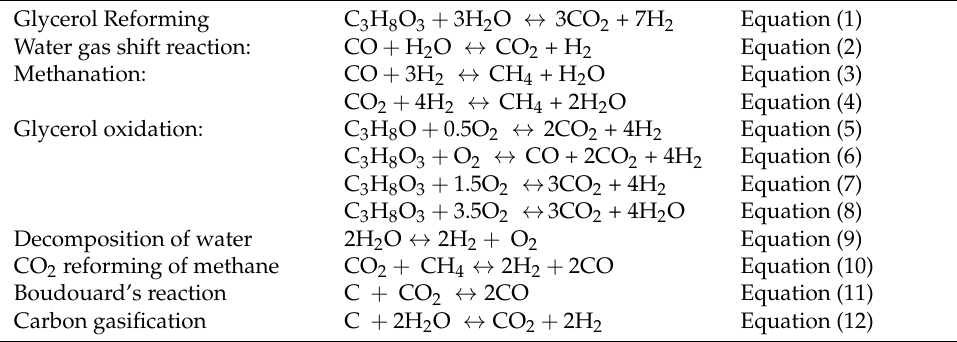
Table 1. Possible reactions in vapor phase glycerol